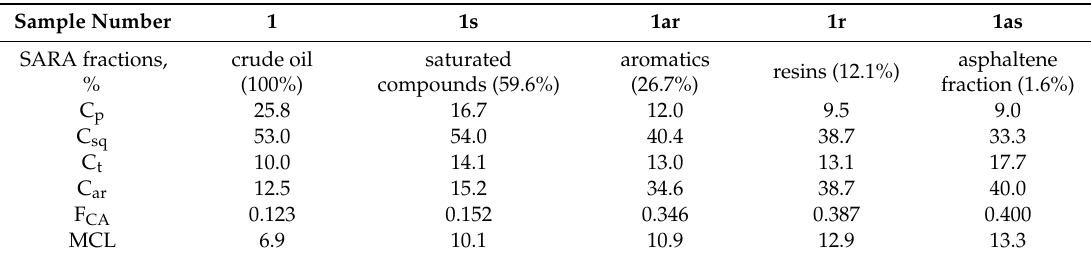
Table 5. Molar fractions (%) of primary (C p ), secondary and quaternary (C sq ), tertiary (C t ), aromatic (C ar ) groups, aromaticity factor (F CA ), and mean chain length (MCL) of aliphatic hydrocarbons based on 13 C NMR spectra of samples 1, 1s–1as.